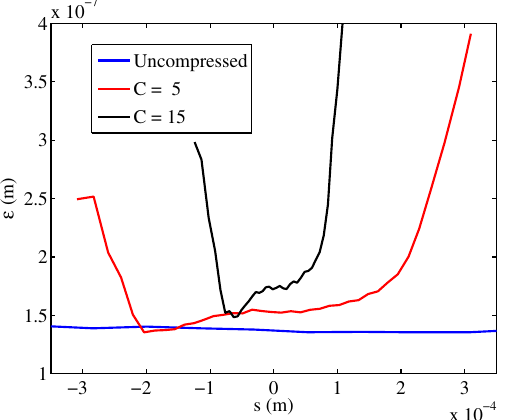
FIG. 11. Simulated horizontal slice emittance along the bunch for two different compression factors using the 3D csr_g_to_p model of CSRT RACK . The horizontal slice emit- tance along the bunch before compression is also shown for comparison.